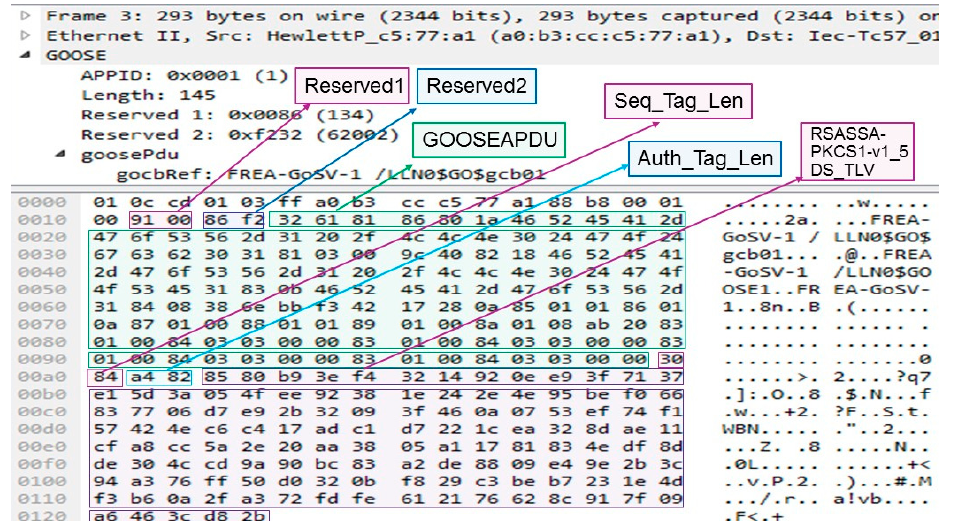
Figure 15. Wireshark capture of GOOSE frame with the extension of RSASSA-PKCS1-v1_5 digital signature.